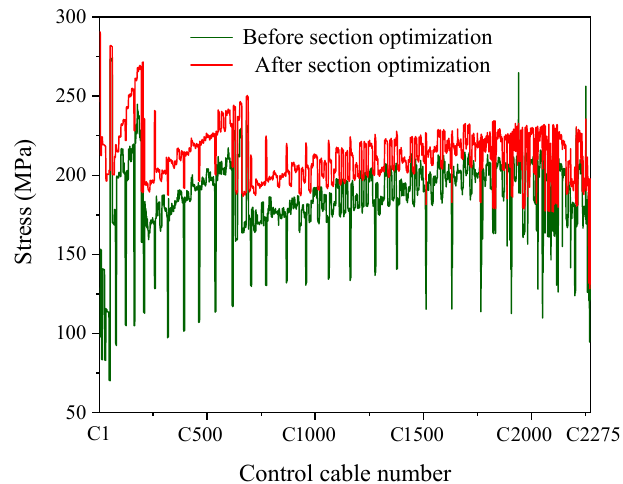
Figure 10. The stress distribution of control cables.